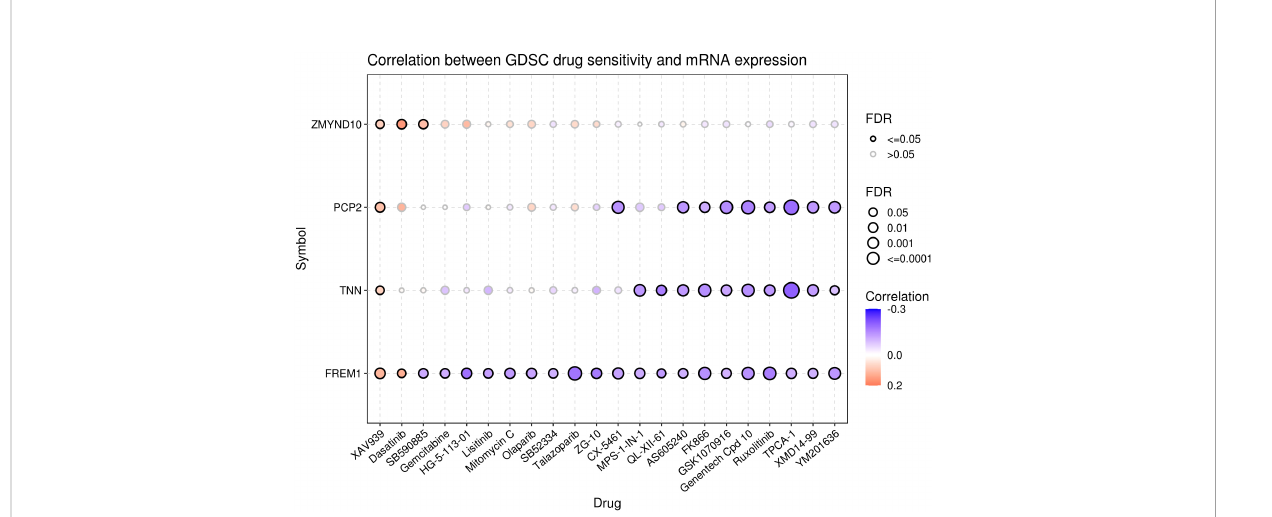
FIGURE 9 Drug sensitivity analysis of the pyroptosis genes. Data from the GSCA database represent the correlation between the expression of proptosis genes and drug sensitivity. A negative correlation indicates that patients with cancer with overexpression of the proptosis genes are sensitive to the drug, and vice